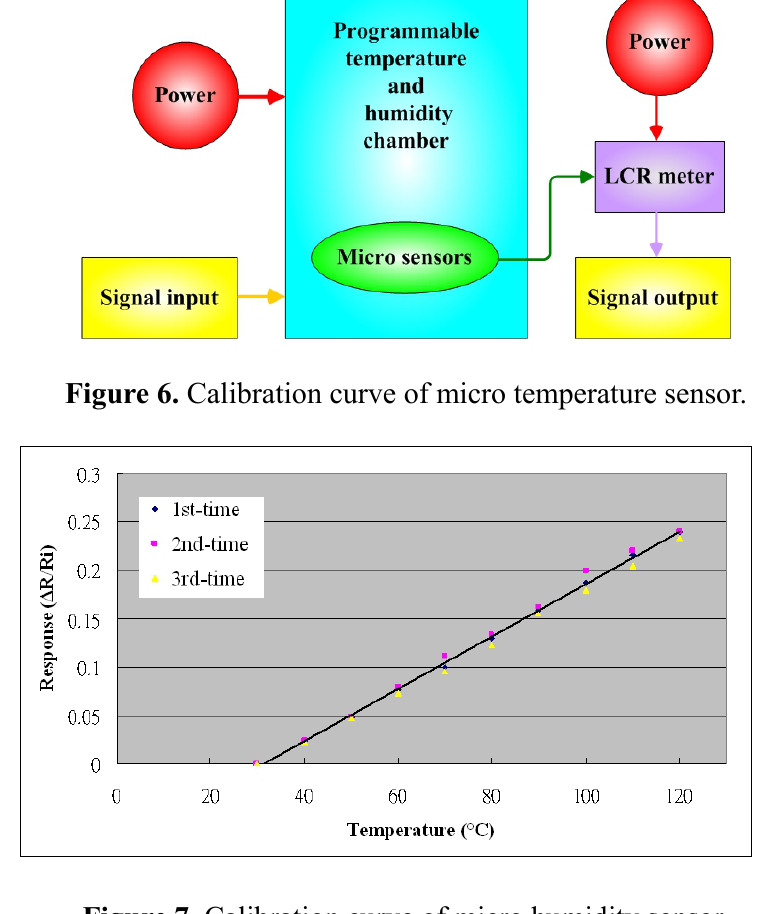
Figure 7. Calibration curve of micro humidity